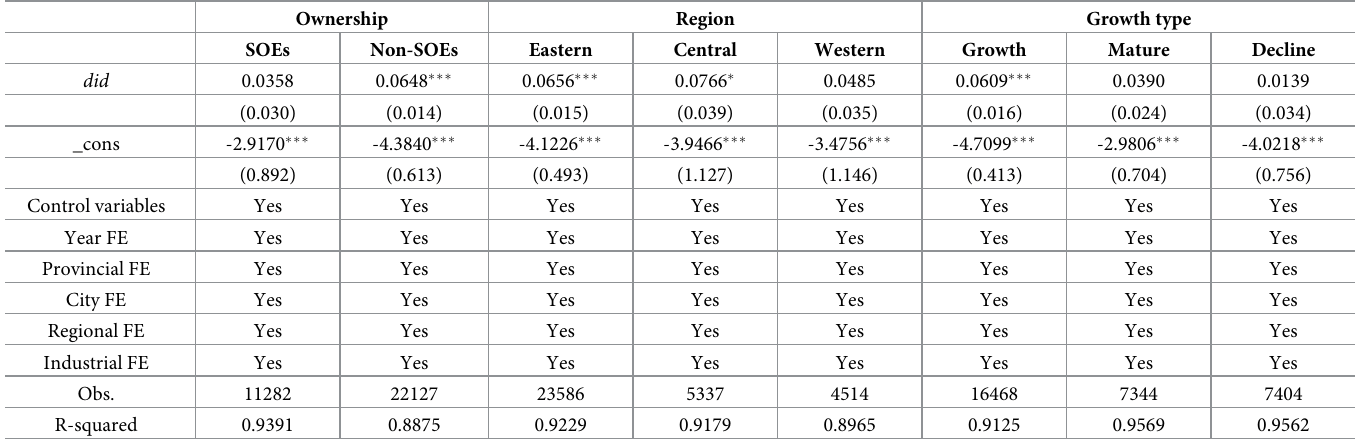
Table 5. Heterogeneity analysis.